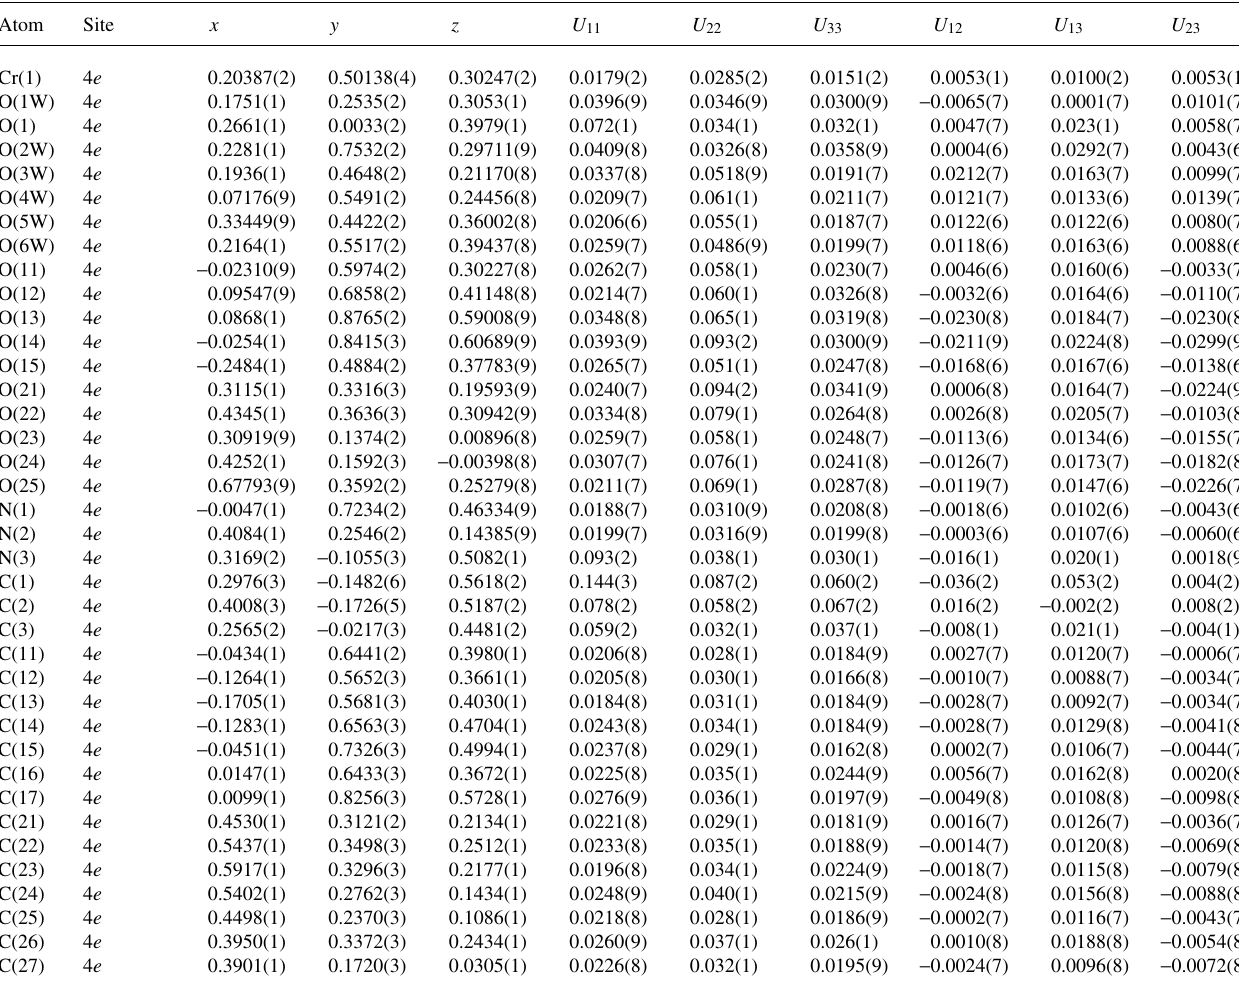
Table 3. Atomic coordinates and displacement parameters (in Å 2 )